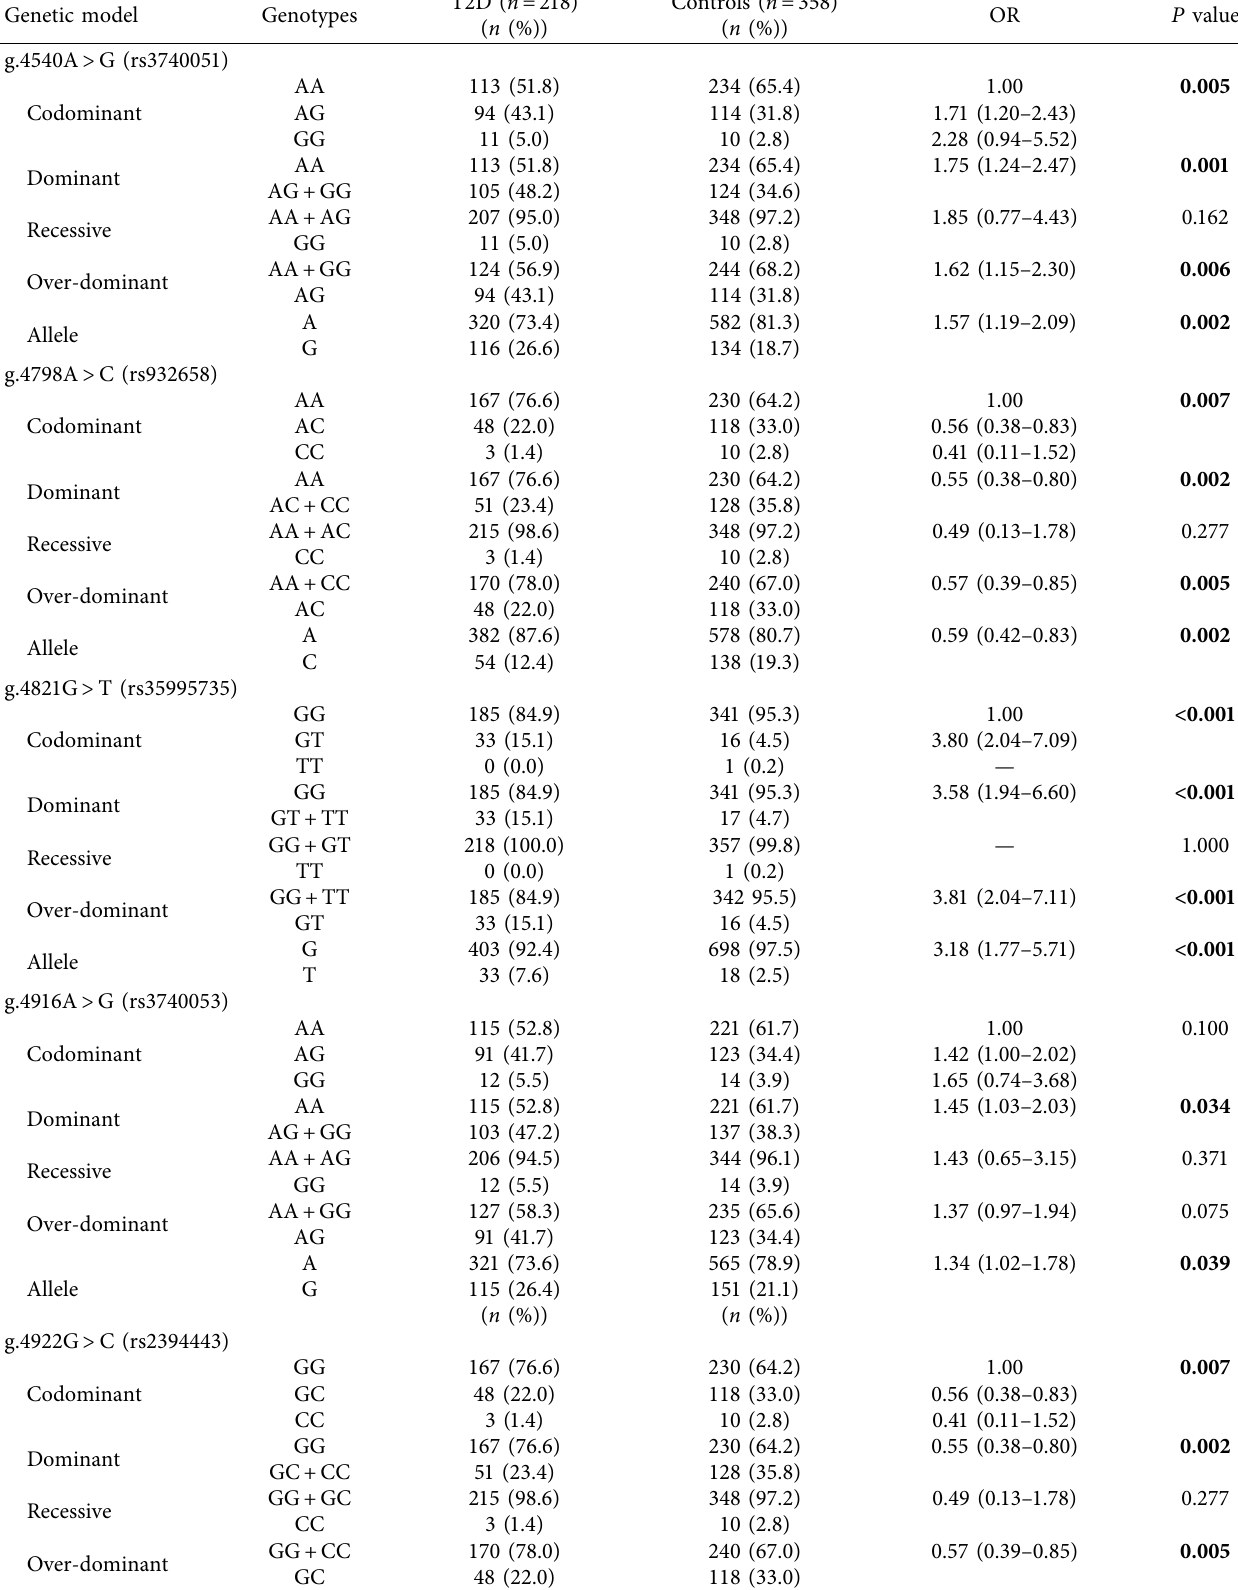
Table 2: Genotype distribution and allele frequencies of the SNPs in T2D patients and